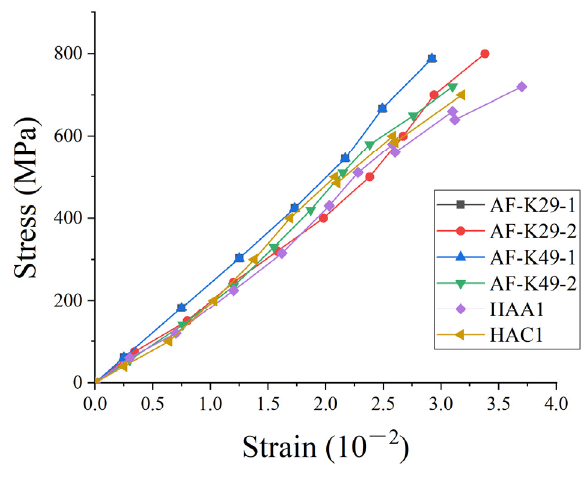
Figure 4. Stress–strain curves of fiber-belt-bars.